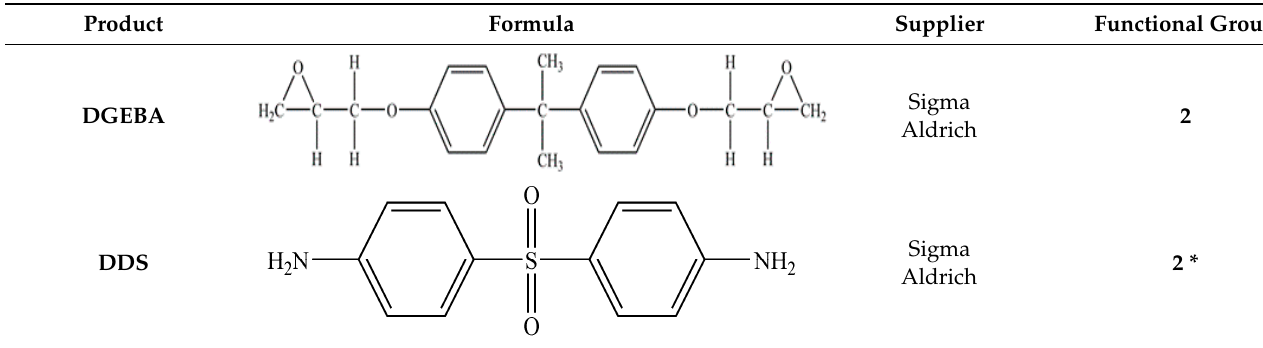
Table 1. Material components.